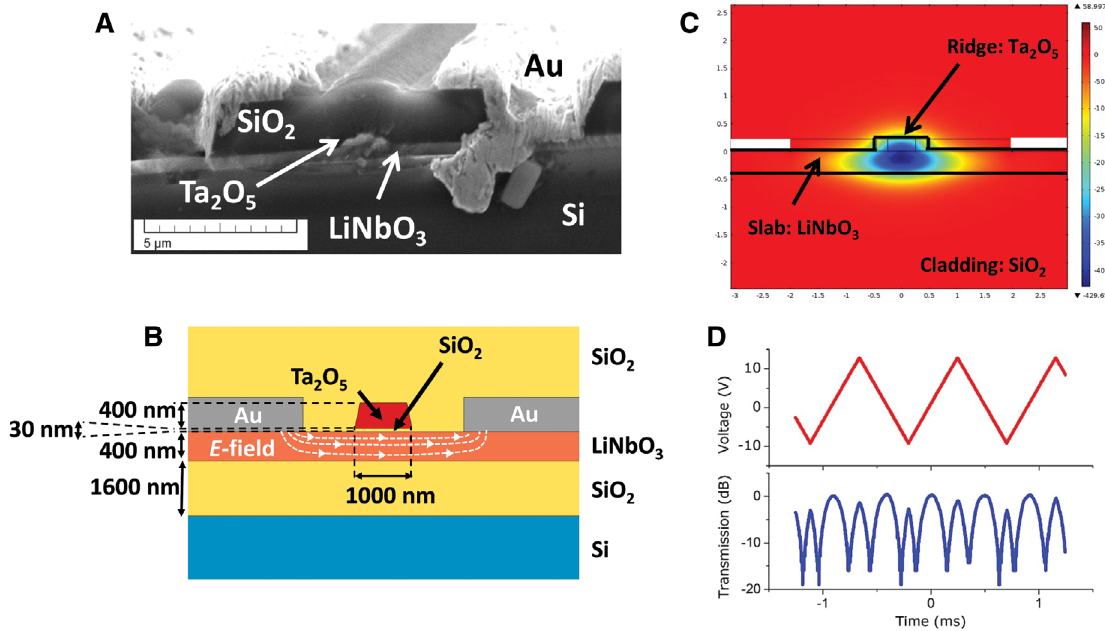
Figure 8 (A) Micrograph, (B) schematic, (C) optical mode simulation and (D) measured modulation response of the first demonstrated LiNbO -on-Si modulators 3